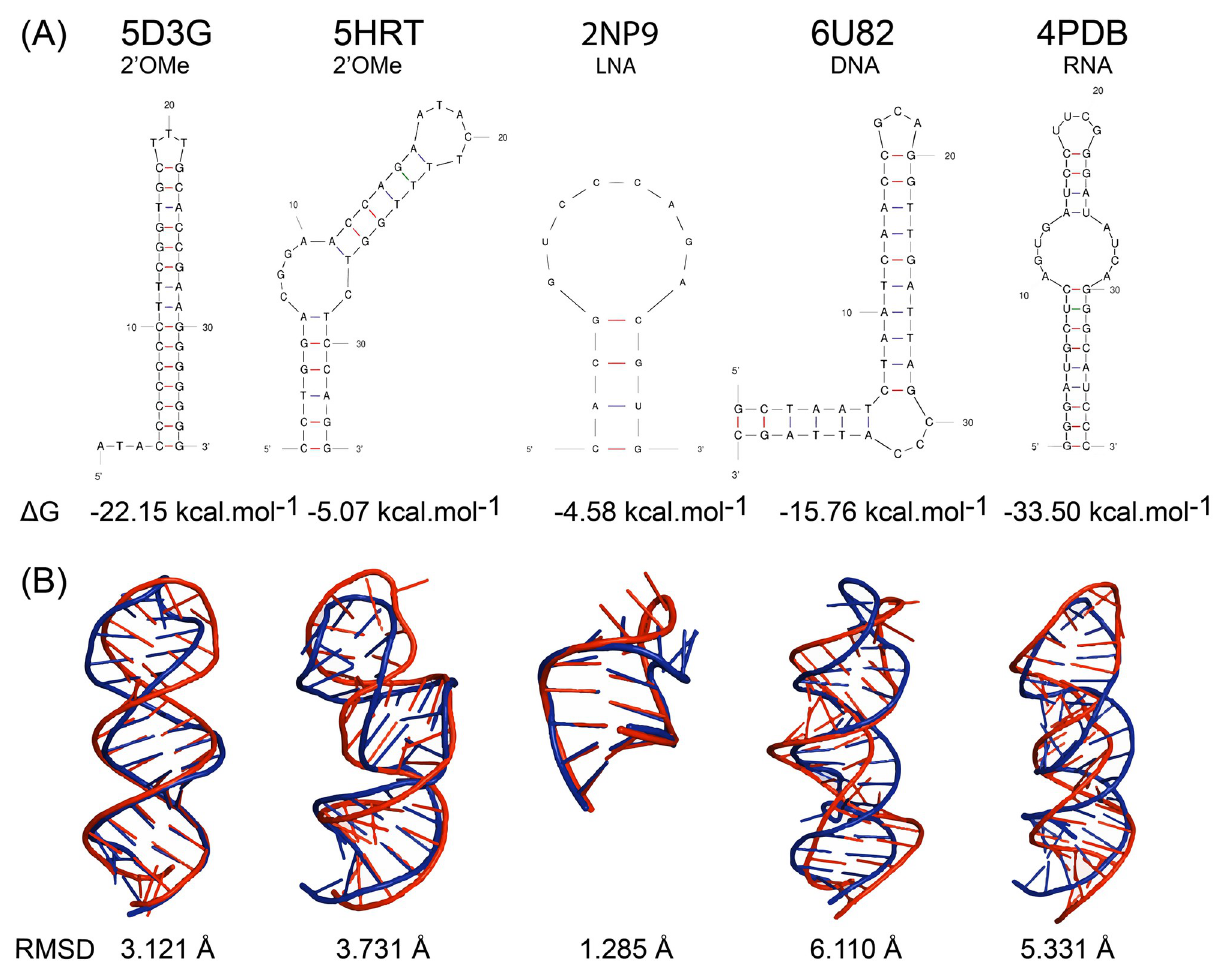
Fig 2. Aptamers’ secondary (A) and tertiary (B) structure obtained after executing the first five steps of the workflow (Mfold, 3dRNA, Biovia, PyMOL and QRNAS). (A) The secondary structures obtained by Mfold and the Gibbs free energy ( Δ G). (B) The overlap of the predicted tertiary structures (in red) and the corresponding experimentally resolved structures downloaded from the PDBe (in blue), and the RMSD